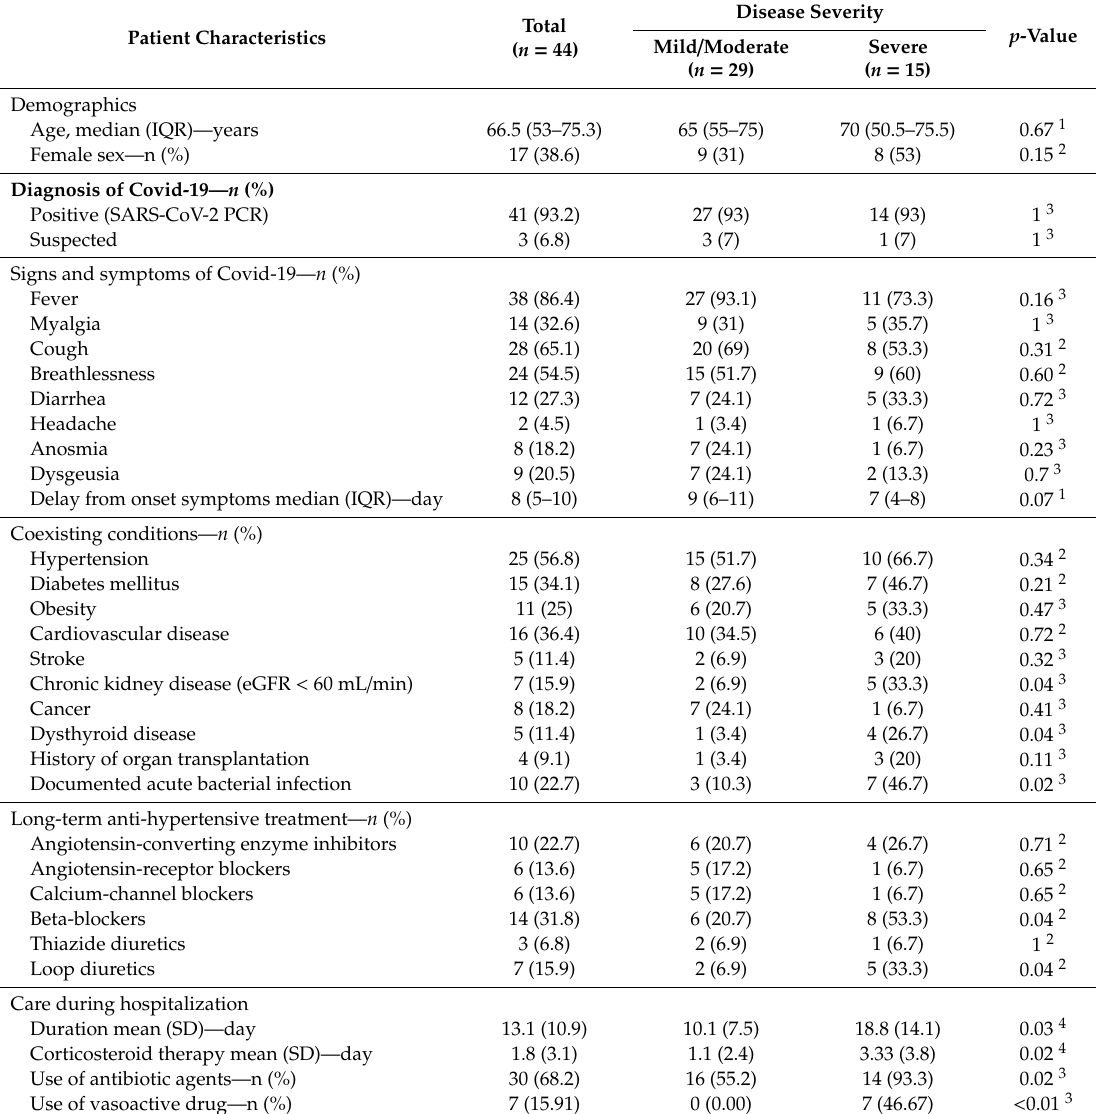
Table 1. Clinical characteristics of patients with Covid-19 according to disease severity classified in two groups: mild / moderate (OS max ≤ 4) and severe (OS max ≥